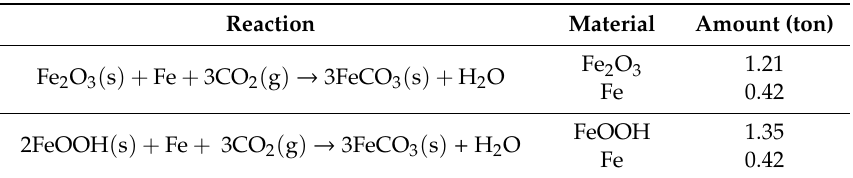
Table 6. Amount of raw material needed to capture 1 ton of CO 2 in several carbonation reactions, assuming 100% of conversion